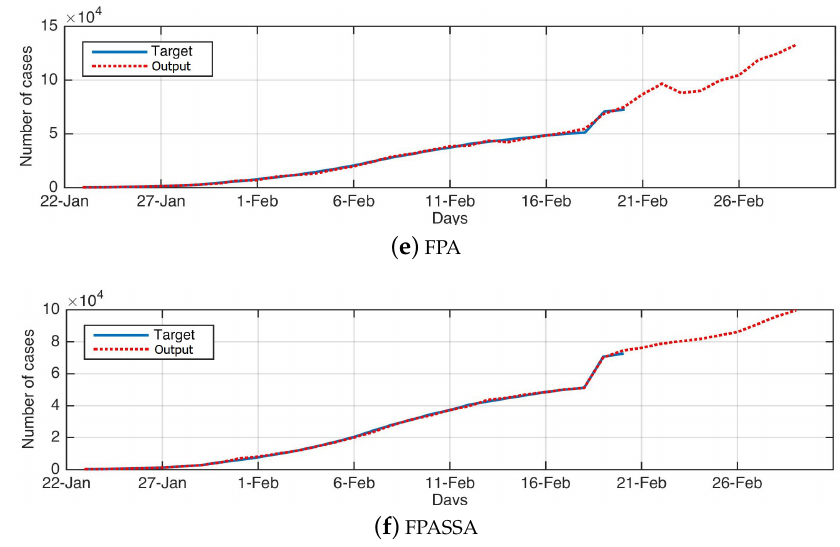
Figure 3. The real data (target) against the forecasted data (output) for all methods.